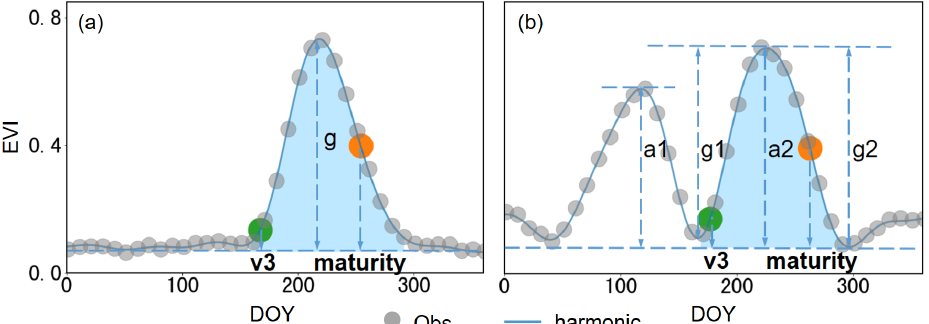
Figure 4. Illustration of mapping long-term mean phenology of spring maize (a) and summer maize (b) . The blue shaded areas represent the growing period of maize. All acronyms are as follows: g : the EVI amplitude of spring maize; g1 and g2 are the EVI amplitudes of green-up and green-down segments, respectively; a1 and a2 are the EVI amplitudes of the first and second cycles, respectively; DOY: day of year.